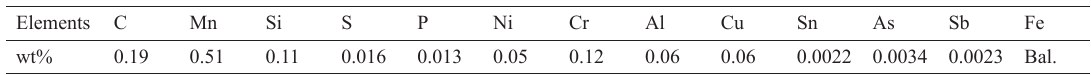
Table 1: Chemical composition of the steel ( in %wt .). Elements